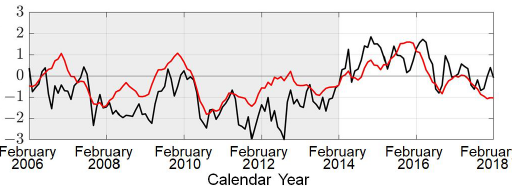
Figure 3. Pacific decadal oscillation (PDO) index ( —— ) [34] and Tripole index (TPI) (——) of interdecadal Pacific oscillation (IPO) [36] between